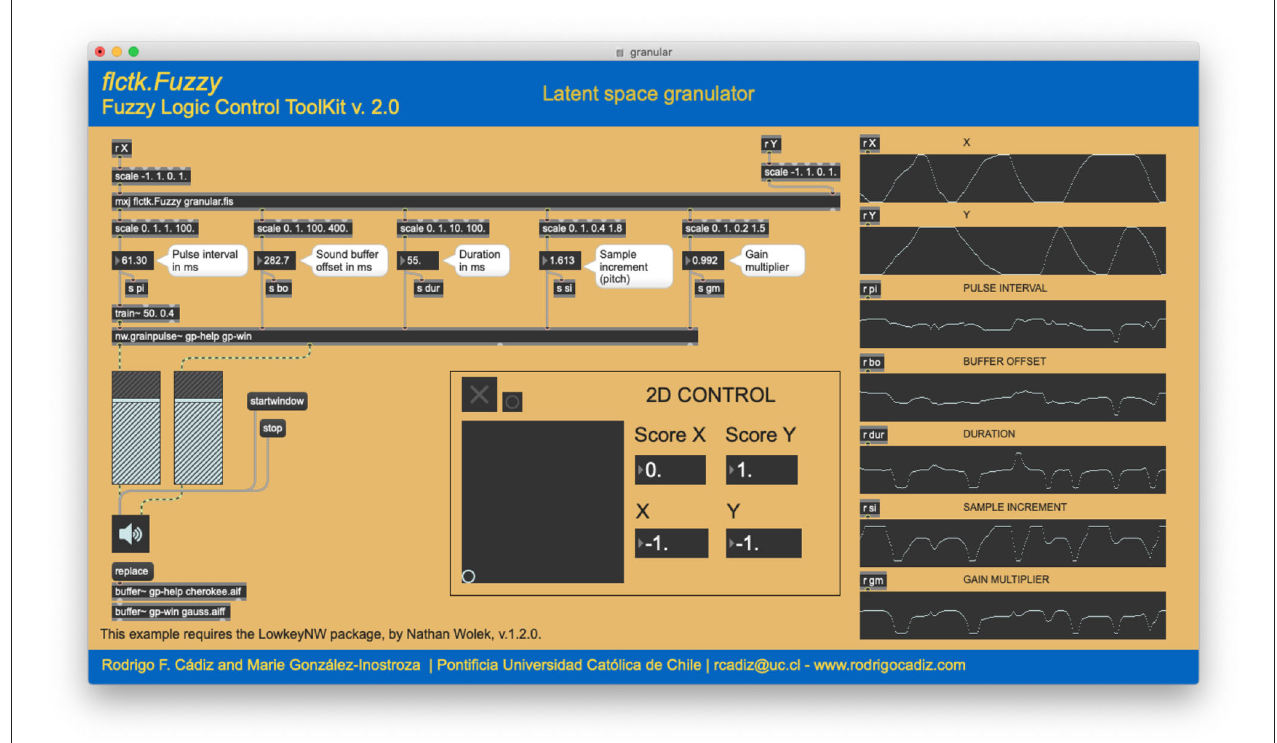
FIGURE 8 | Latent space granulator example. Inputs and outputs of the fuzzy system are displayed on the right. As the latent space is explored in both the X and Y directions, the output variables exhibit different non-linear behavior. This allows the parametric control of five synthesis parameters with only two abstract parameters.